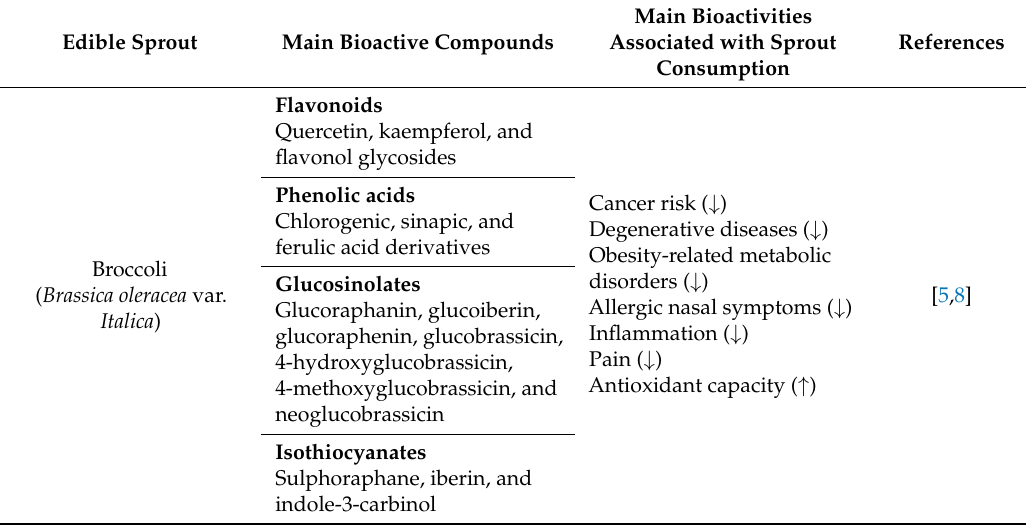
Table 1. The main bioactive phytochemicals and health promoting activities of diverse raw edible sprouts. Edible